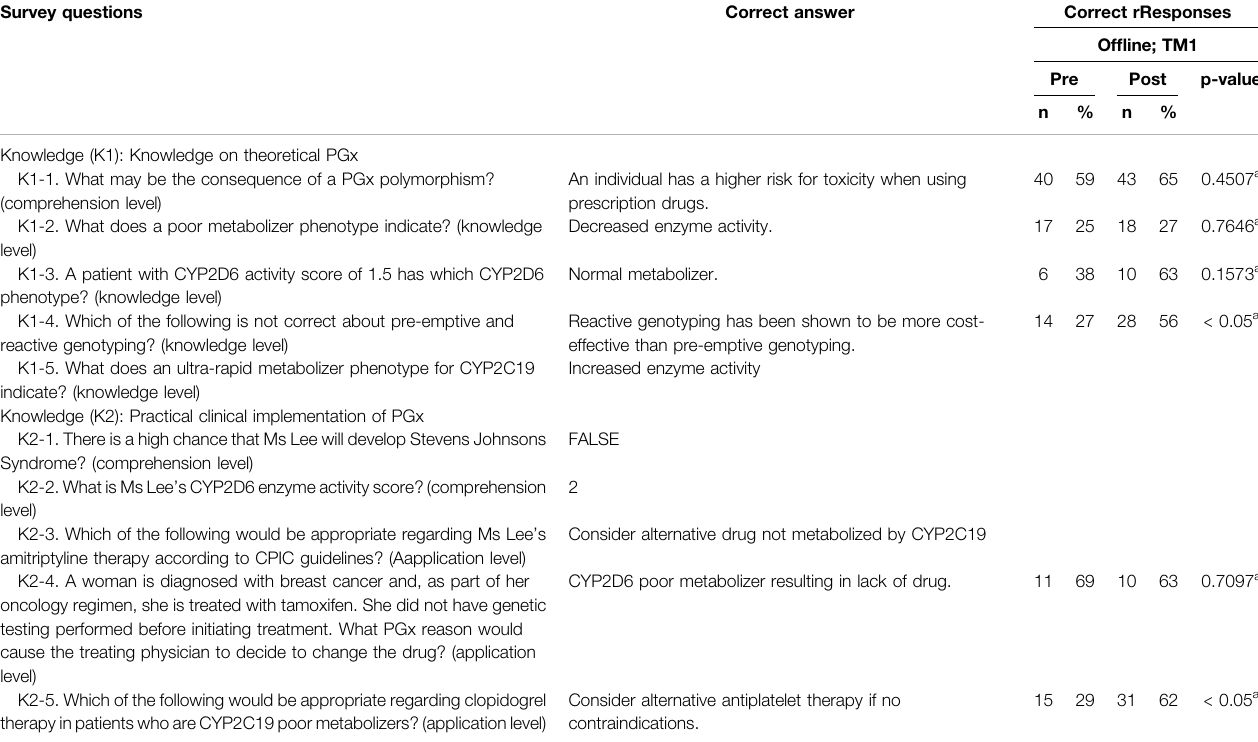
TABLE 3 | Correct responses to questions about knowledge on PGx comparing pre- and post- of fl ine training for